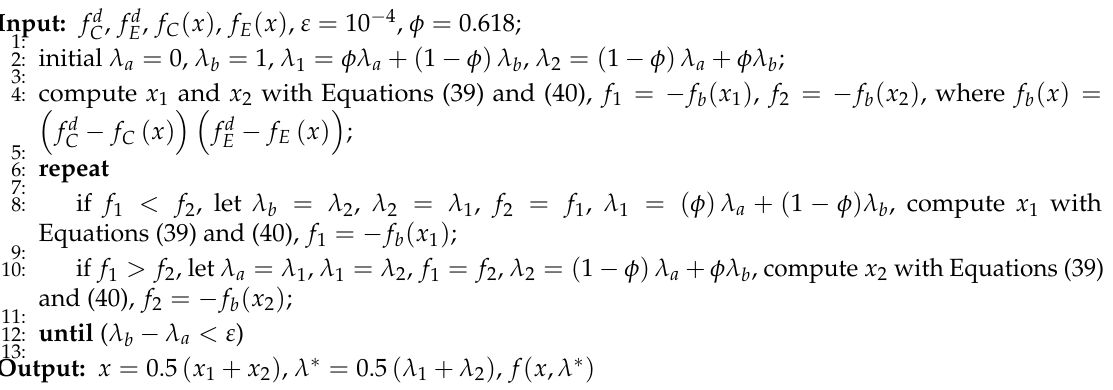
Algorithm 1 Golden Section Search for Nash Bargaining (Equation (38)).